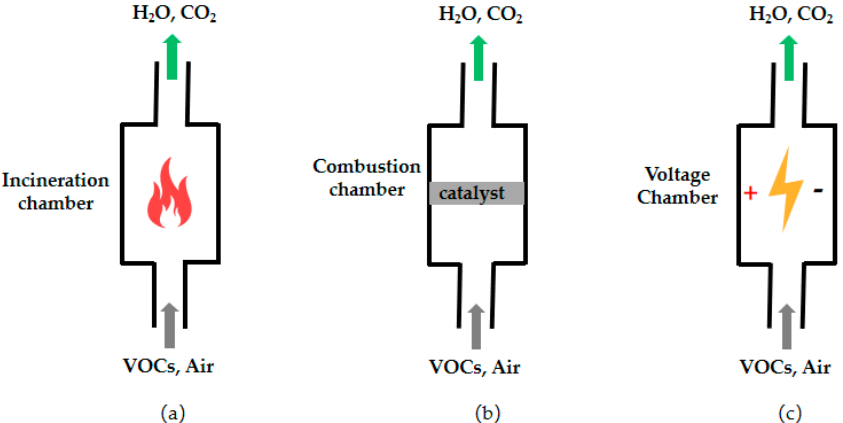
Figure 4. Schematic diagram of the three related purification methods: ( a ) thermal oxygen incinera- tion; ( b ) catalytic combustion; ( c ) low-temperature plasma.